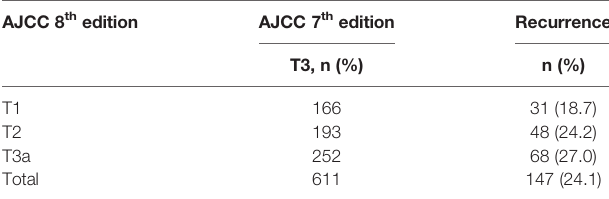
TABLE 4 | Pathological tumor stage migration of AJCC 7 th edition T3 tumors and incidence of